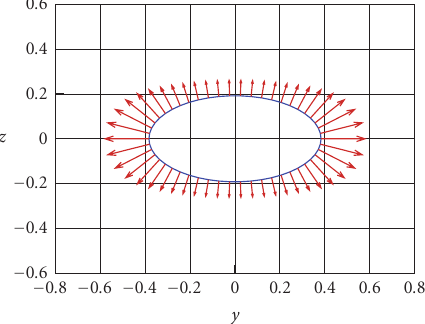
Figure 6.10. Normal stress ( T nn n y + T nn n z ) / 600dyn/cm 2 for an ellipse y 2 /b 2 + z 2 /c 2 = 1 − 2 . 9 2 /a 2 at x = 2 . 9 cm in the ( y , z )-plane. Perpendicular view of the cross section (i) in Figure 6.1. The strong tension observed near the trailing stagnation point may explain the formation of a two-dimensional cusping tail in a gas bubble rising in viscoelastic